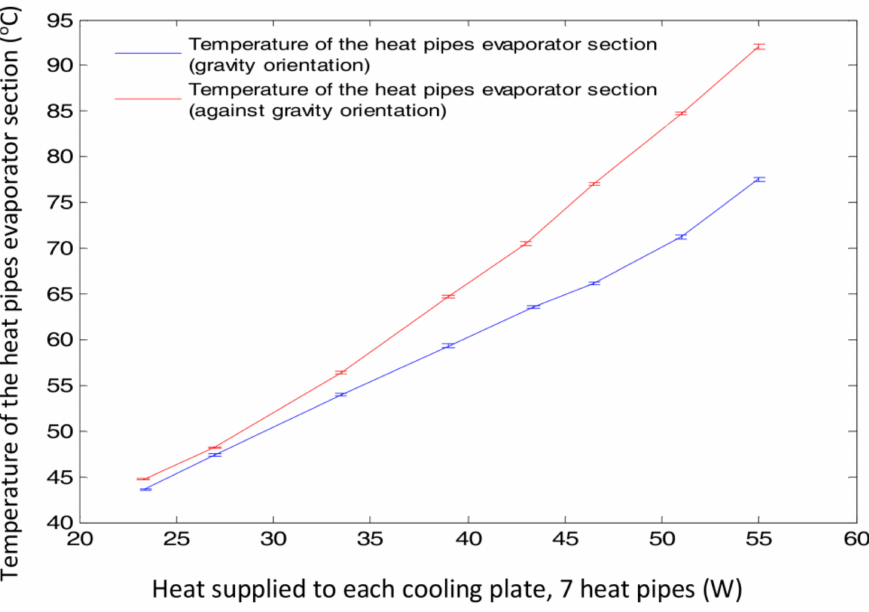
Figure 7. Steady temperature of the heat pipes evaporator sections (diameter of 6 mm, effective length of 190 mm pressed thickness of 2 mm and width of 8.50 mm at the evaporator section) as a function of heat supplied by a DC power supply for gravity and against gravity orientations (maximum 1% error is associated with the data for